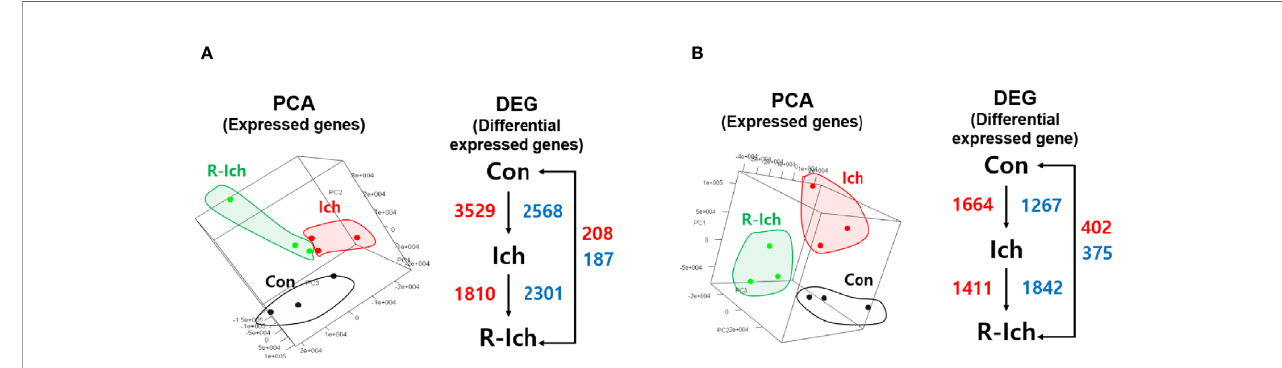
( Figure 2 and Table S4 ). Metabolism (ko01100), RNA transport (ko03013), and the spliceosome (ko03040) were the fi rst, second, and third most highly up-regulated pathways, respectively, while focal adhesion (ko04510), Rap1 signaling (ko04015), and ECM- receptor interactions (ko04512) were the most down-regulated pathways in the head kidney ( Table S4 ). Likewise, 18 and 12 pathways were selected as the top 10% up- and down- regulated pathways, respectively, in the liver during I. multi fi liis infection ( Figure 3 and Table S5 ). The proteasome (ko03050), protein processing in the endoplasmic reticulum (ko04141), and the lysozyme (ko04142) were the top three up-regulated pathways, while endocrine resistance (ko01522), MAPK signaling (ko04013), and circadian rhythm (ko04710) were the three most down-regulated pathways in the liver ( Table S5 ).